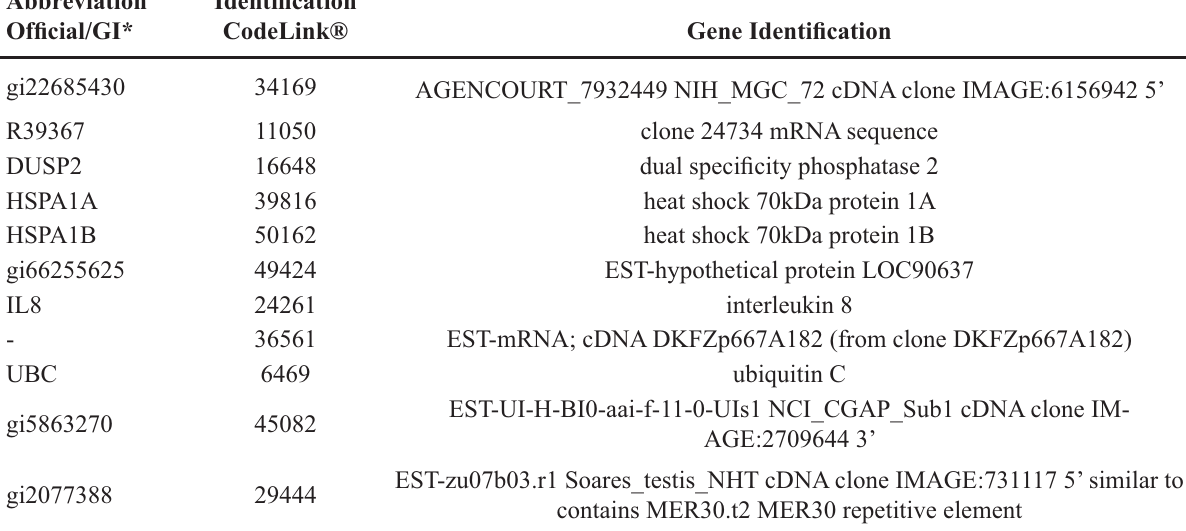
Table 2 – Genes with higher expression from low-risk to metastatic